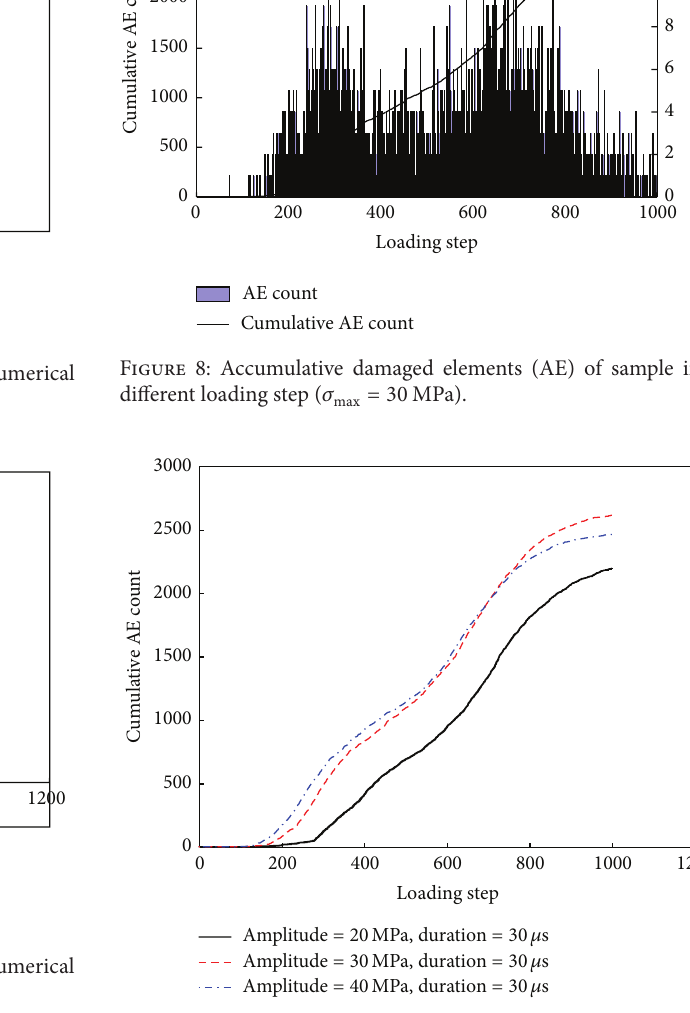
Figure9:ThevariationofaccumulatedcountsofAEunderdifferent stress wave